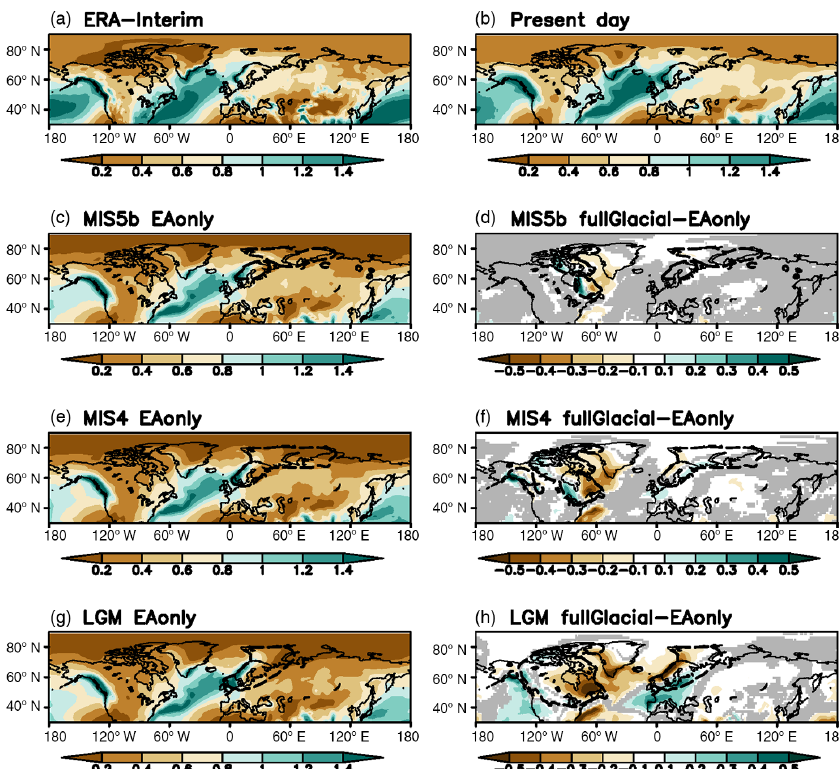
Figure 5. Annual precipitation (in m) from (a) the ERA-Interim climatology (Dee et al., 2011), (b) the present-day simulation, and the EAonly simulations (with PI OHT) of (c) MIS5b, (e) MIS4, and (g) LGM. The annual precipitation anomalies induced by the North American ice sheet (the difference between the fullGlacial and EAonly simulations; in m) are shown in (d, f, h) for (d) MIS5b, (f) MIS4, and (h) LGM. The dashed black contours depict the outlines of the Kleman et al. (2013) ice-sheet reconstructions in Eurasia and North America. Only significant changes at 95% (based on Student’s t test) are shown in (d, f, h) (nonsignificant changes are displayed in